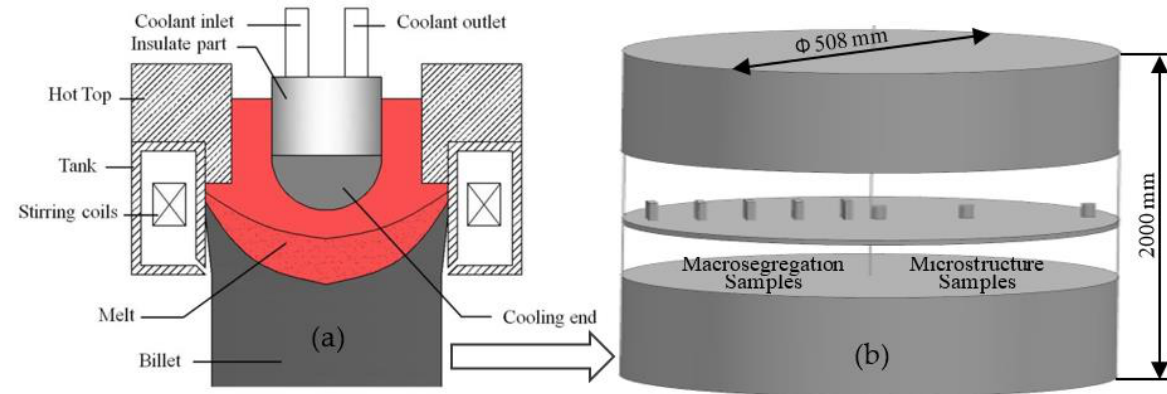
Figure 1. Schematic illustration of the uniform direct chill (UDC) casting process ( a ) [21] and sampling location of billet for structural inspection and chemical composition measurement ( b ). Table 1. Casting process parameters of normal direct chill (NDC) and